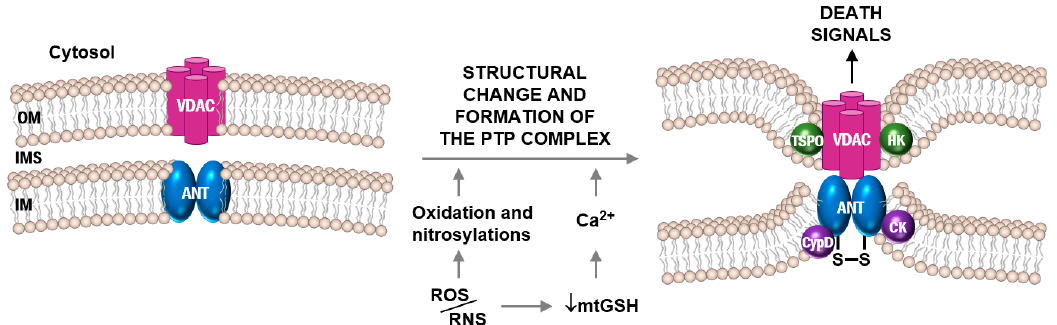
Figure 2. Opening of the mtPTP complex preceding apoptotic motor neuron death during ALS pathophysiology. The voltage-dependent anion channel (VDAC) and mitochondrial adenine nucleotide translocator (ANT) are both dimers located in the outer and inner membranes, respectively. High membrane potential in normally functioning mitochondria keeps the mitochondrial permeability transition pore (mtPTP) closed. Under pathophysiological conditions such as oxidative / nitrosative stress, the mtPTP opens, allowing the entry of H 2 O and solutes. Thus, causing mitochondrial swelling and release of apoptosis-initiating factor (AIF) and cytochrome c from the intermembrane space (IMS), which ultimately results in apoptosis. ROS / RNS cause mtGSH depletion and, consequently, higher levels of intramitochondrial free Ca 2 + , oxidation of critical redox-sensitive –SH groups of the ANT (e.g., Cys56; which, under physiological conditions, are in equilibrium with matrix GSH), and decreased mitochondrial membrane potential. All these factors can trigger structural changes leading to the formation of the mtPTP complex. Translocator protein (TSPO), hexokinase (HK), creatine kinase (CK), and cyclophilin D (CypD) are the other components of mtPTP. Outer membrane (OM), inner membrane (IM).